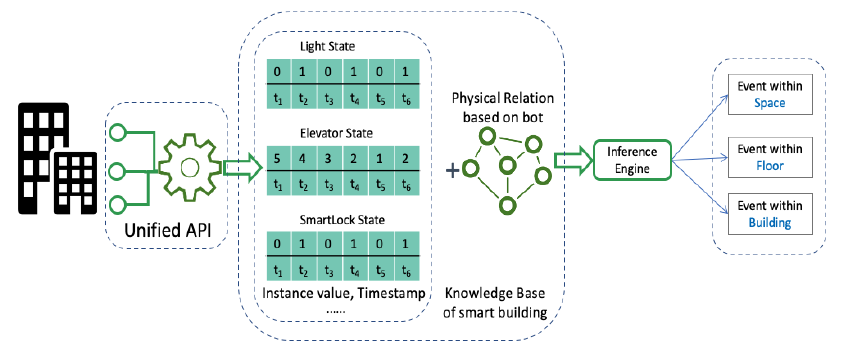
Figure 2. Overview of our proposal for knowledge extraction.